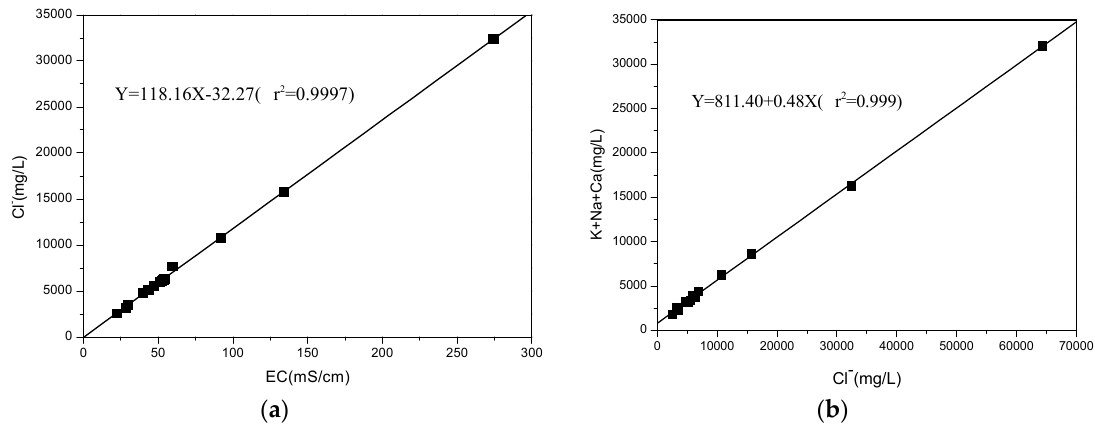
Figure 8. Regression analysis of chloride concentrations against EC values ( a ) and the sum of the concentration of Ca, K and Na against chlorides ( b ) for the leachates.